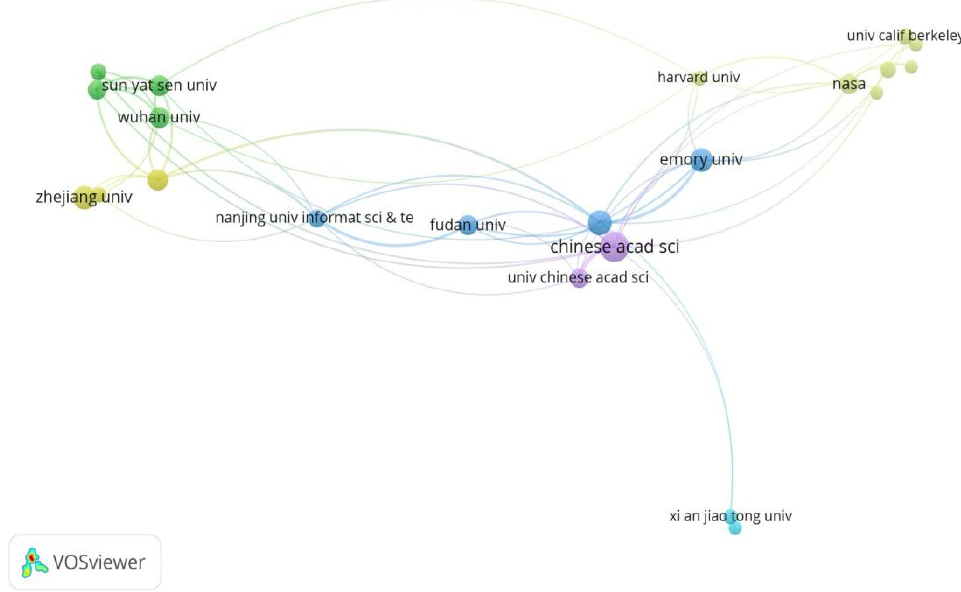
Figure 6. Map of prominent co-authorship of organizations. Table 5. Top 5 productive